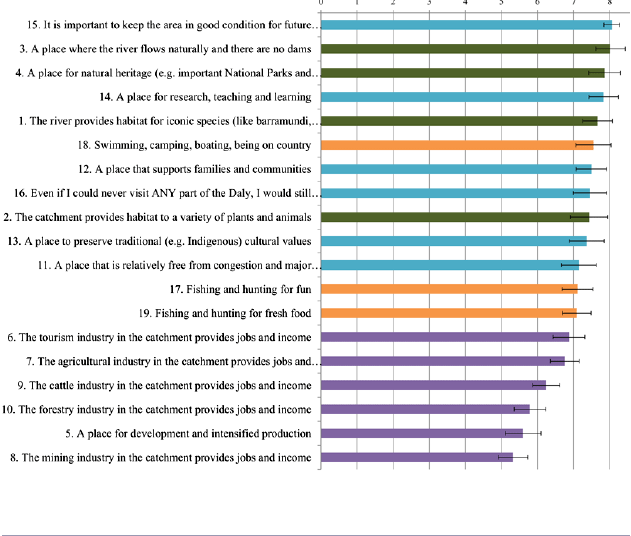
Fig. 3 . Mean importance values and confidence intervals for 19 well-being factors. Color of bar indicates the domain: biodiversity (green), commercial (purple), social-cultural (blue), recreational (orange).